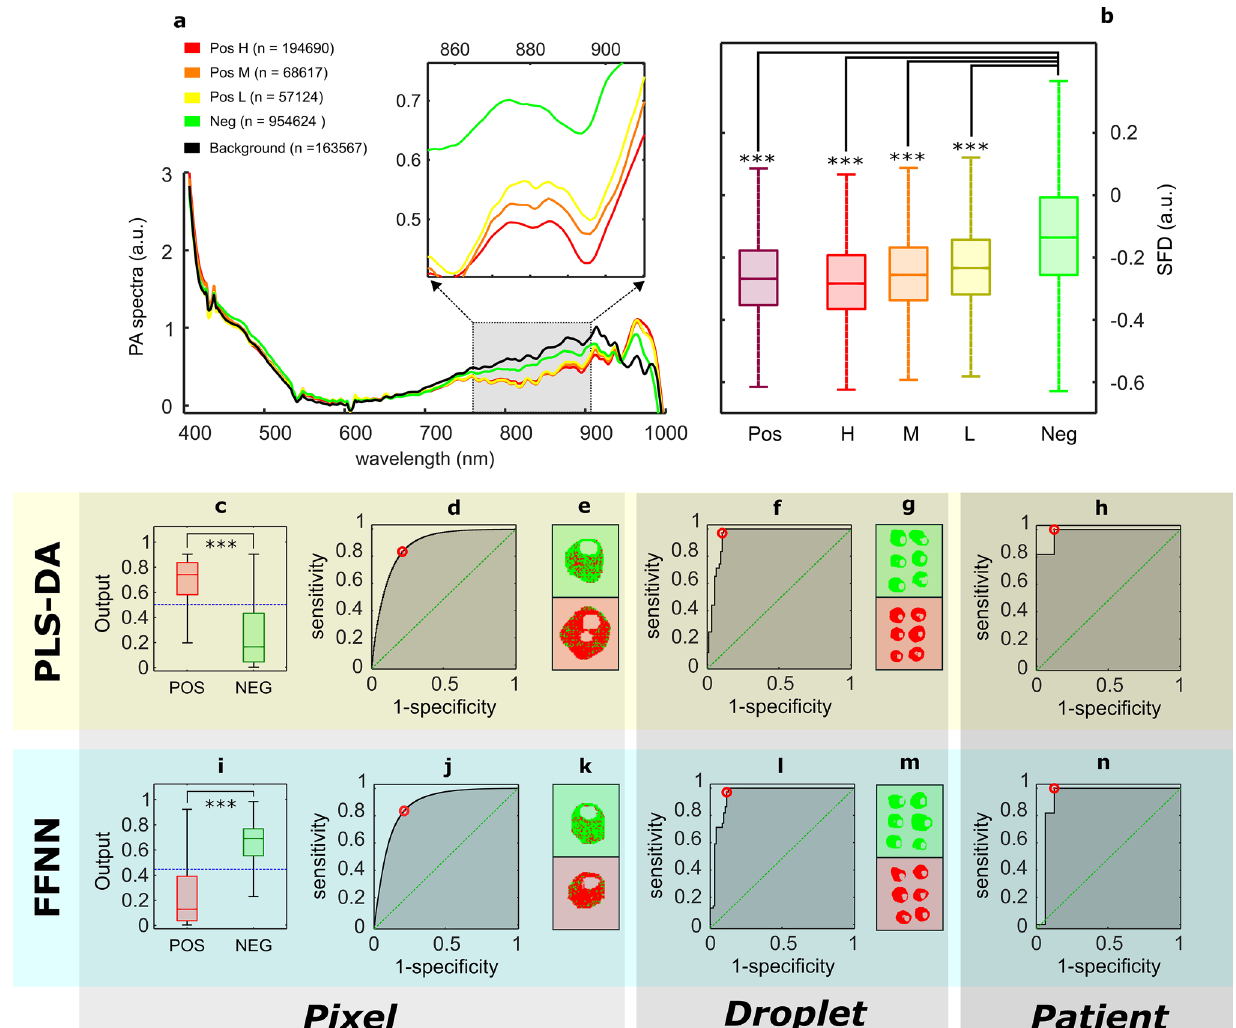
Figure 3. Experiment 2: Analysis of SARS-CoV-2 nasopharyngeal exudates. ( a ) Mean pseudo-absorbance (PA) pixel spectra from positive (viral loads H = 10 6 copies mL −1 (high), M = 10 4 copies mL −1 (medium) and L = 10 2 copies mL −1 (low)) and negative cases of SARS-CoV-2. In addition, the panel shows the mean pixel spectra of the supporting plate (background). ( b ) Value of the spectral feature descriptor (SFD) in the band between 870 and 910 nm for all cases. Positive (Pos) box includes all H, M and L samples. ( c–h ) Classification results obtained using partial least square-discriminant analysis (PLS-DA Model 2, Trial 1). ( i–n ) Classification results obtained using a feed-forward neural network (FFNN, Trial 1). ( c,i ) Median value of the output used for pixel classification. Positive and negative samples were determined by qRT-PCR. ***p-value = 0 using Wilcoxon rank-sum test. The blue dashed line illustrates the classification threshold. ( d,j ) Receiver operating characteristic (ROC) curves from the pixel classification. ( e,k ) Example of the resulting pixel classification in a droplet. Red and green pixels were classified as positive and negative respectively. Note red and green backgrounds indicate a positive sample and its negative control. ( f,l ) ROC curves obtained from droplet classifications. ( g,m ) Example of the classification of several droplets from a positive (red background) and a negative (green background) patient. ( h,n ) ROC curves obtained from patient diagnosis. Outliers were removed for